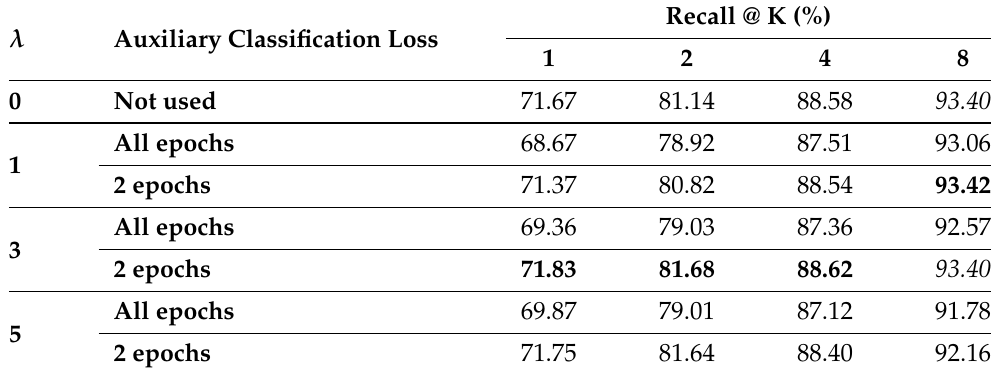
Table 2. The table shows whether the existence of the auxiliary module is beneficial to the overall performance. The row ‘2 Epochs’ indicates that the auxiliary module was implemented for only first two epochs. The bold values are the best performances in each recall @